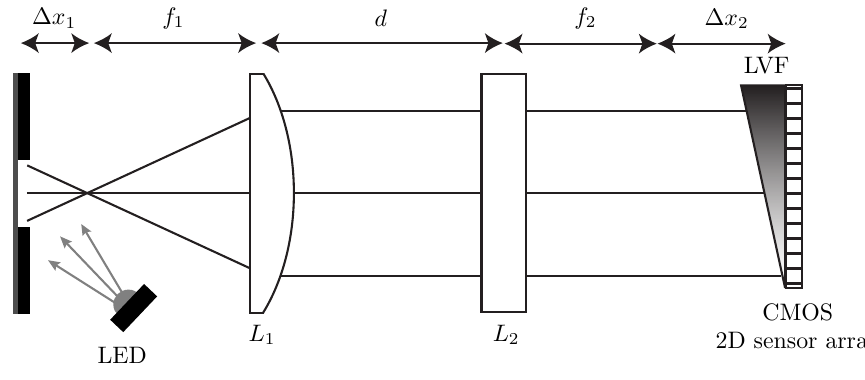
the sensor has a resolution of eight bits and the exposure time can be chosen between 35 µs and 980 ms. The complete measurement setup in the plan and side view is shown in Figures 2 and 3. Figure 2. Illustration of the proposed hyperspectral fluorescence spectrometer based on an LVF/CMOS 2D sensor array configuration. In the top view of the measurement setup, the ray path of the fluorescence with the spectral information is shown. The lens adjustment consisting of a plano-convex spherical lens and a plano-convex cylindrical lens enlarges the information of the fluorescent measurement object over the complete CMOS 2D sensor array. Due to the assembly of the plano-convex cylindrical lens, this dimension contains the spectral information to a corresponding location of a considered measurement object.